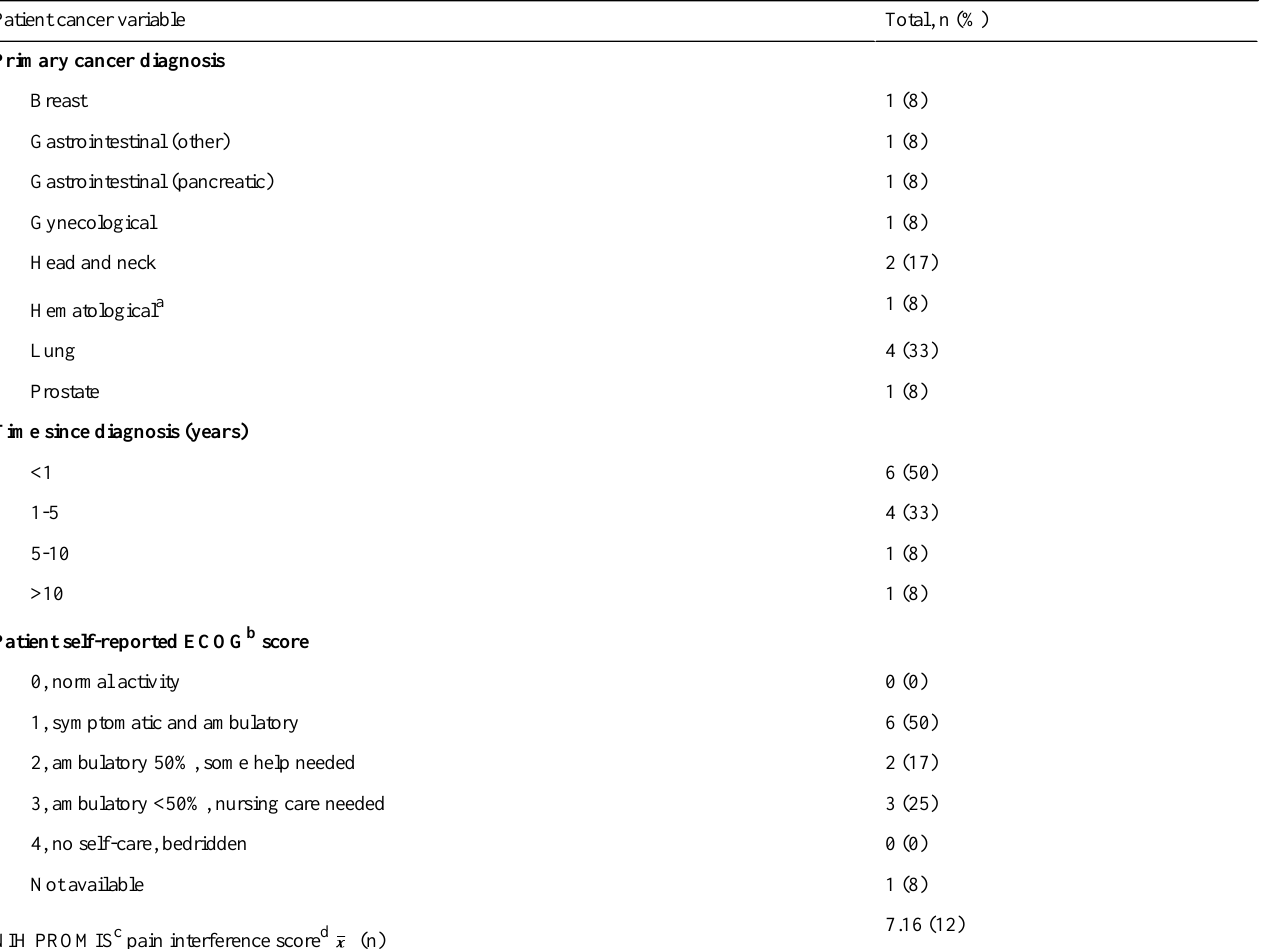
Table 2. Patient sample cancer characteristics